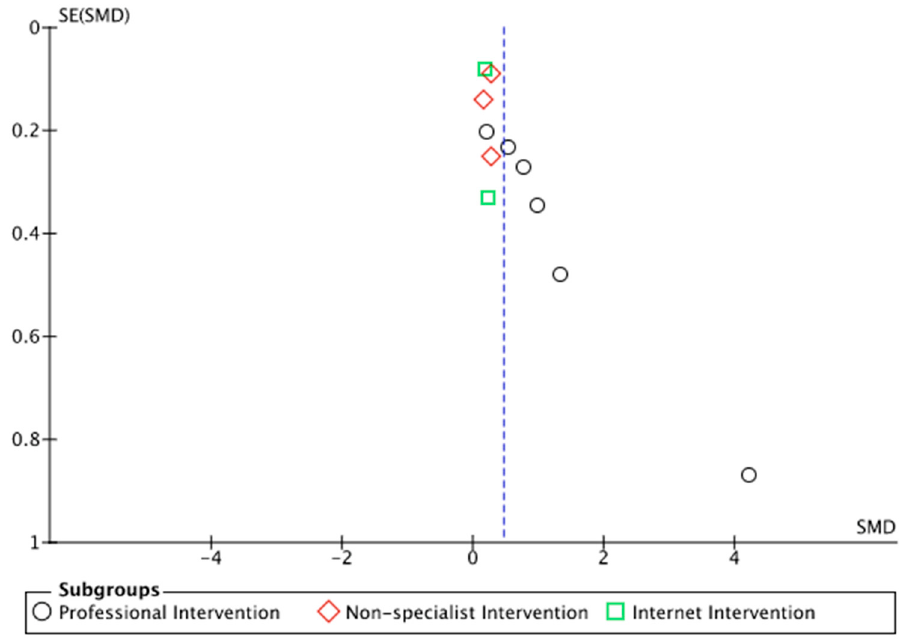
Figure 2. The funnel plot of subgroup of PTSD outcome studies. Comparison of Mental-Health-Professional-Delivered Mental Health Interventions versus Control